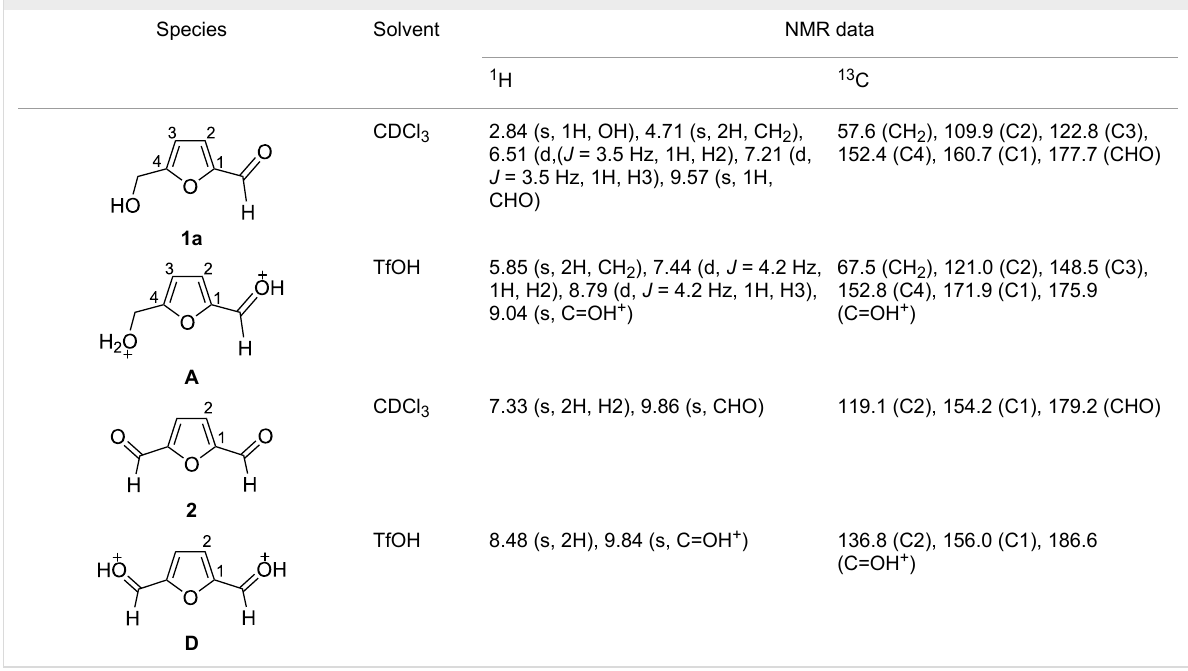
Table 2: 1 H and 13 C NMR data of furans 1a, 2 in CDCl 3 and species A , D in TfOH at room temperature. Species